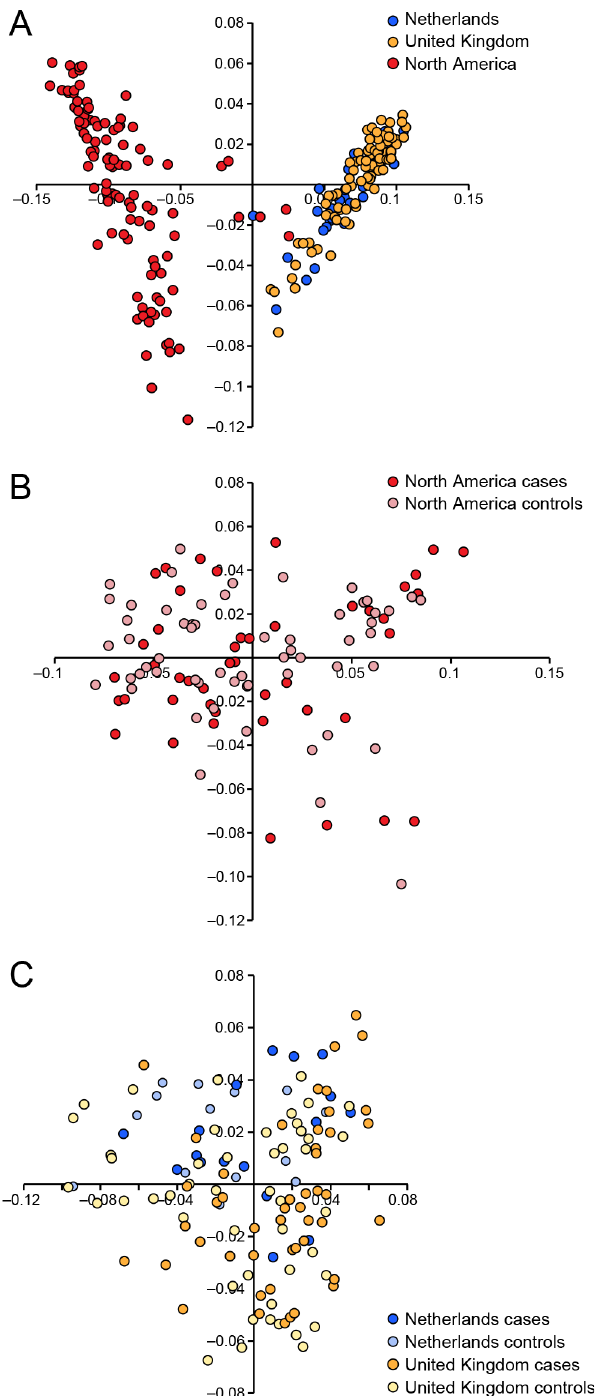
Fig 1. Multiple dimensional scaling plot visualising the genetic similarity between the individuals within the population using the two first principal components as calculated in PLINK. a) American and European data combined b) American data c) European